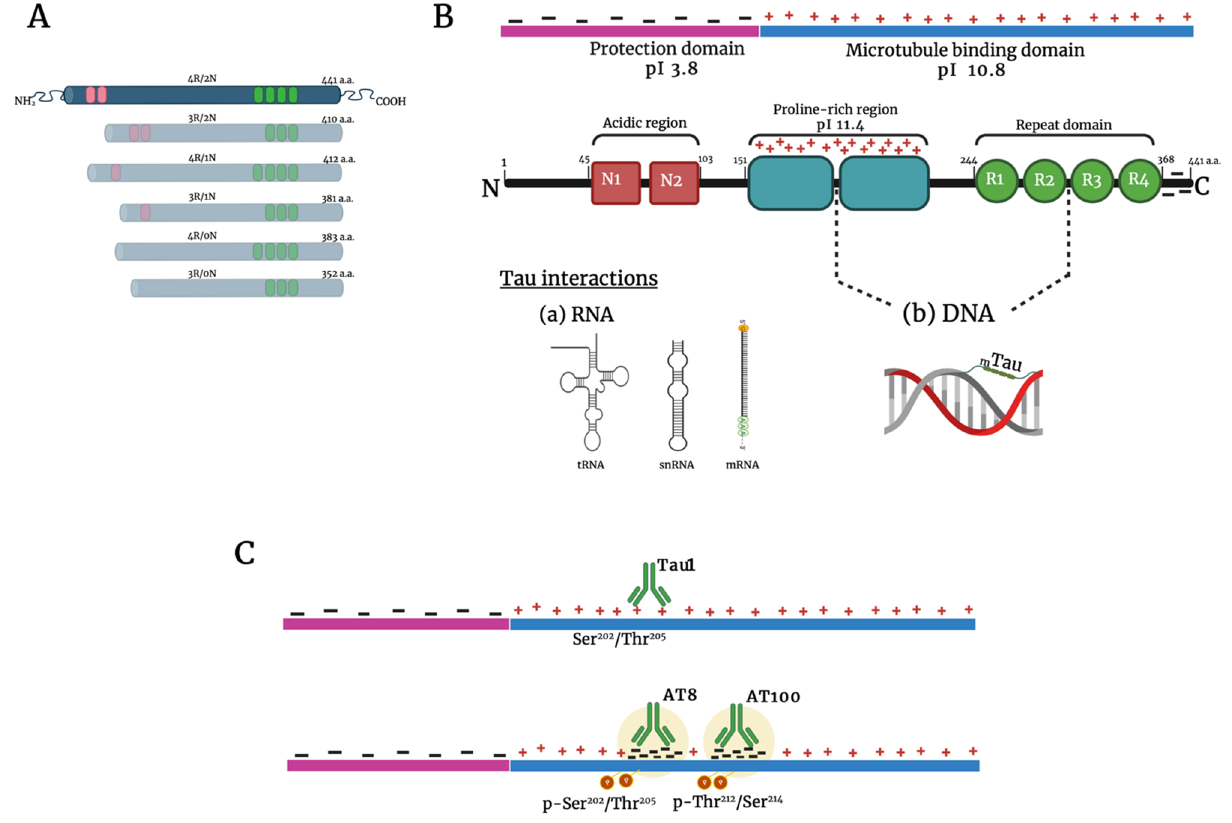
Figure 1. Tau protein structure and nuclear interactions. Structure of the six tau isoforms expressed in the adult human brain ( A ). Details of the longest isoform. It contains three major domains: an acidic N-terminal part (red), a proline-rich region (blue), and the basic microtubule-binding domain (green). The electrostatic interactions between domains allow the formation of condensed liquid tau droplets. The dotted line indicates the region where tau interacts with DNA and RNA ( B ). Upper line: Tau1 antibody recognizes the Ser202/Thr205 site. Lower line: The antibodies AT8 and AT100 bind with the phosphorylated sites Ser202/Thr205and Thr212/Ser214, respectively. Notice the change in the charge of the protein upon phosphorylation ( C ). Abbreviations: pI, regional isoelectric points; a.a., amino acids. Created with BioRen- der.com.